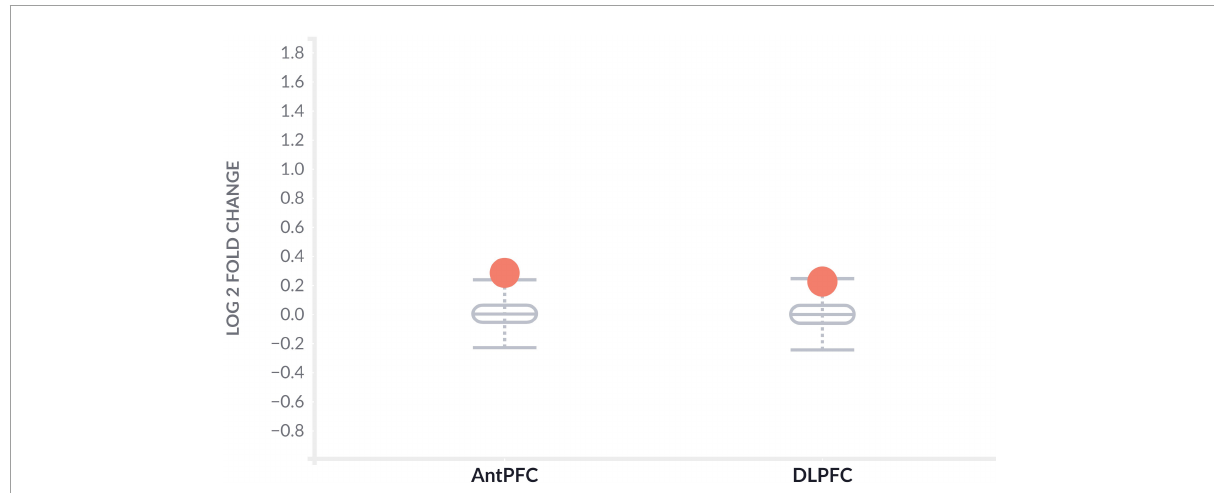
FIGURE2 Differential protein expression of CLU between AD and normal samples. The gray boxplots represent the expression levels of CLU protein in the brain tissues of healthy participants. The orange dots represent the expression levels of CLU protein in the brain tissues of AD patients. AntPFC, anterior prefrontal cortex; DLPFC, dorsolateral prefrontal